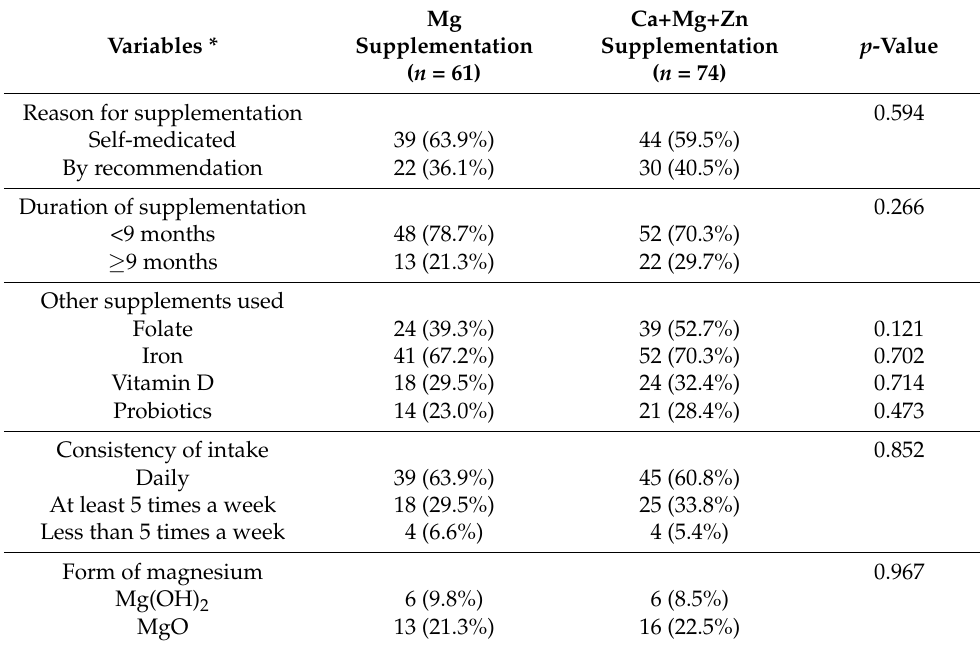
Table 2. Summary of nutritional supplementation in the study cohort, stratified by type of micronu- trient